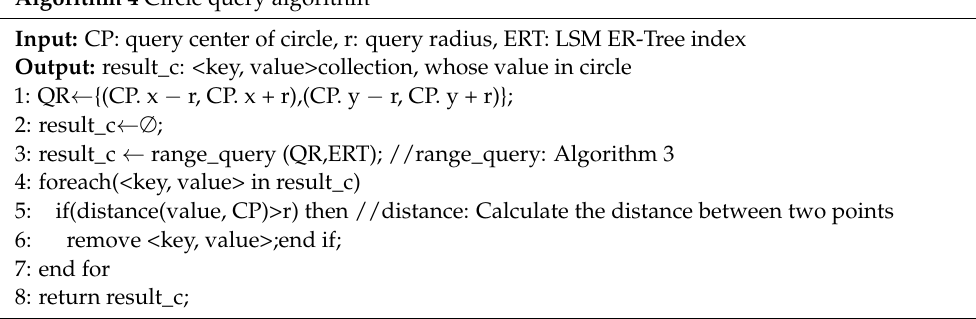
Algorithm 4 Circle query